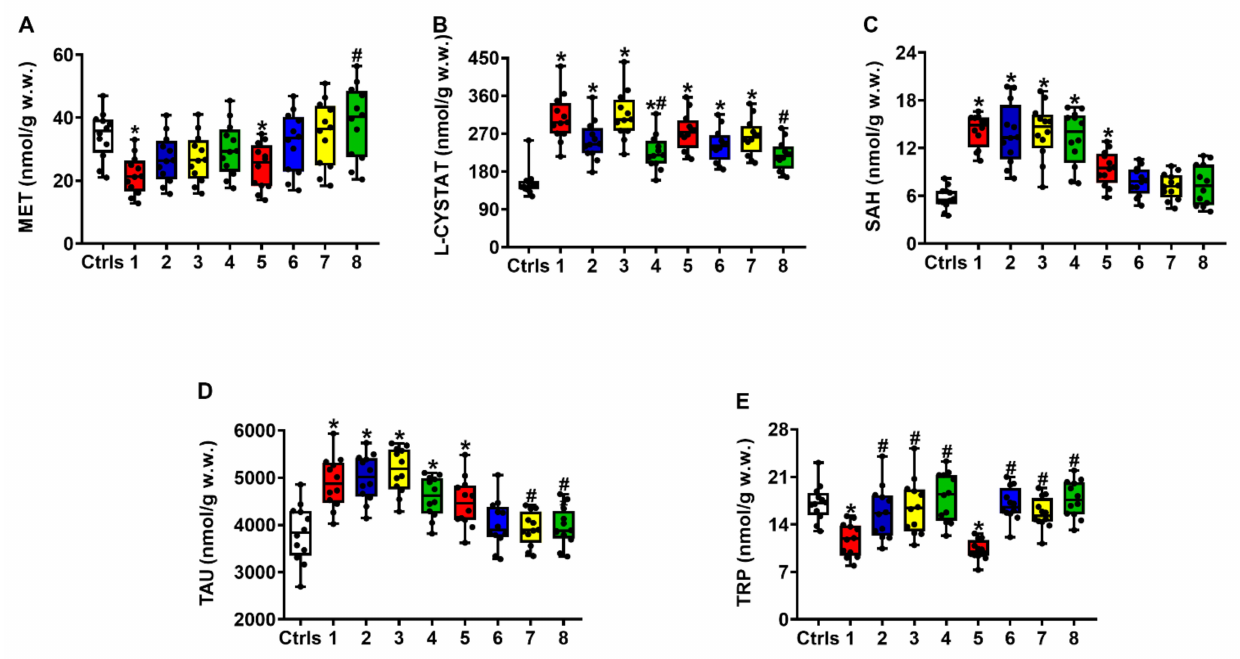
Figure 4. The box plots reporting all data points ( • ), minimum, maximum, median, 25 and 75 percentiles of Met ( A ), L-Cystat ( B ), SAH ( C ), Tau ( D ) and Trp ( E ), in rats without and with the s.c. administration of increasing ILB ® doses (1, 5 and 15 mg/kg b.w.). Ctrls = control sham- operated rats; 1 = sTBI only, sacrificed at 2 days post-injury; 2 = sTBI + 1 mg/kg b.w. ILB ® , sacrificed at 2 days post-injury; 3 = sTBI + 5 mg/kg b.w. ILB ® , sacrificed at 2 days post-injury; 4 = sTBI + 15 mg/kg b.w. ILB ® , sacrificed at 2 days post-injury; 5 = sTBI only, sacrificed at 7 days post-injury; 6 = sTBI + 1 mg/kg b.w. ILB ® , sacrificed at 7 days post-injury; 7 = sTBI + 5 mg/kg b.w. ILB ® , sacrificed at 7 days post-injury; 8 = sTBI + 15 mg/kg b.w. ILB ® , sacrificed at 7 days post-injury. * Significantly different from controls, q < 0.05. # Significantly different from corresponding time of untreated sTBI rats, q <